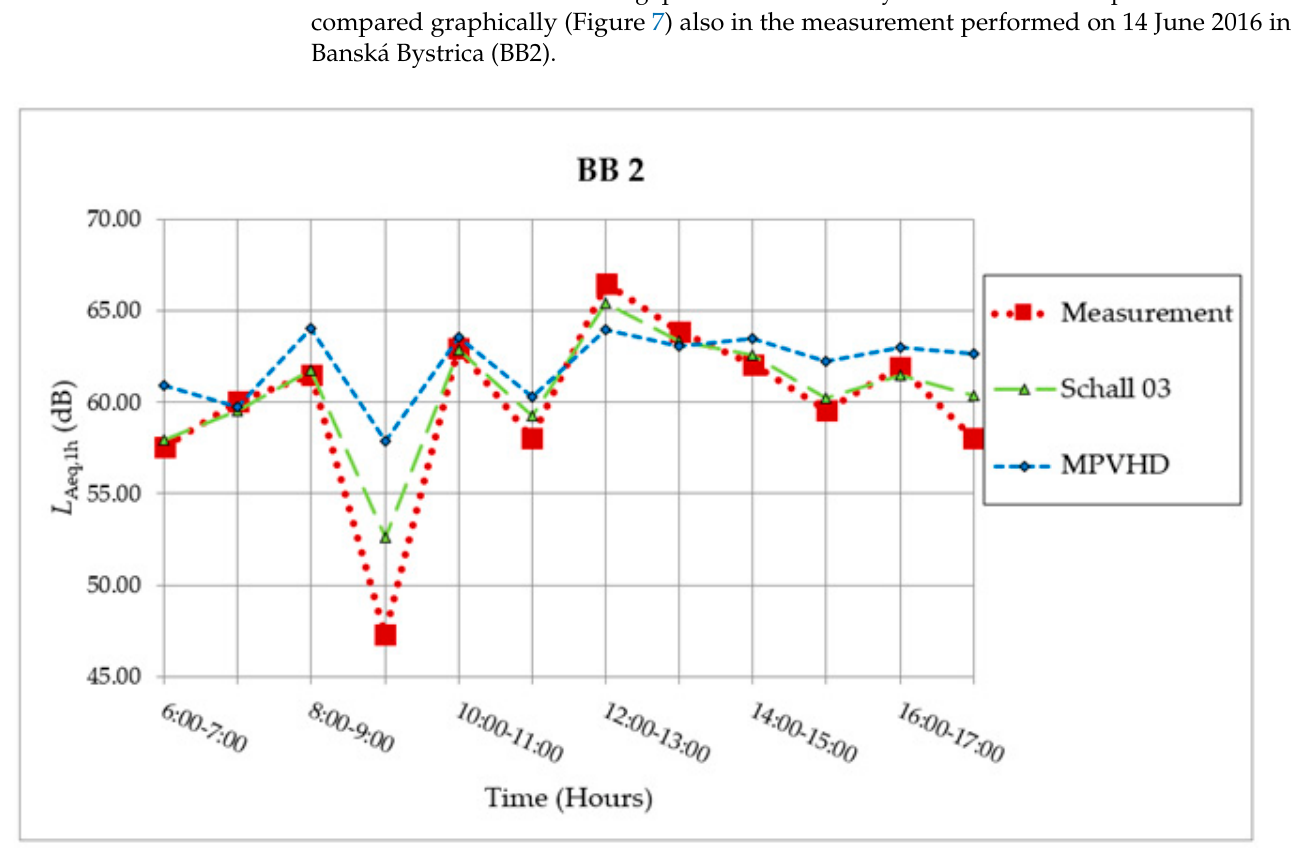
Figure 7. Measurement and prediction of noise from the railway on measurement location BB2 [30]. The maximum noise exposure was reached in the time interval from 12:00 a.m. to 1:00 p.m., although during this measurement hour only three trains passed near the BB2 location. However, one of the trains was freight, had 21 wagons, and passed in the direction of Vrútky-Banská Bystrica. The passage of the longest freight train was not recorded until the following hour. This train had 3 locomotives and 26 wagons, but it passed in the direction of Banská Bystrica - Č ervená Skala, i.e., on the line, which was twice as far from the measuring point. Although he passed 32 s longer, the L AE sound pressure level A was more than 5 dB lower. Between 9:00 a.m. and 10:00 p.m., only the passage of one motor passenger train with two wagons was recorded. A motor passenger train is a special train that is relatively short and moved with non-uniform movement. It was therefore prob- lematic to determine its speed and had a significantly different noise level than the basic noise emission level determined by both prediction models. As a result, the noise expo- sure at the given measuring point was the smallest. Train speeds ranged from 35 km/h to 75 km/h (average speed was 50 km/h). The equivalent sound pressure level A at the ref- erence time “day” for BB2 was L Aeq,12h = 61.58 dB. The course of determining quantities obtained by measurements and prediction methods has a similar tendency in this case as well. In the time interval between 9:00 a.m. and 10:00 a.m., the predictions are significantly overestimated by both methods (espe- cially in the case of MPVHD), at that time only one motor passenger train crossed through the assessed section. The sensitivity of both methods to this extreme situation is lower again. Box plots were also used in this measurement. The graph in Figure 8 again presents a comparison of L Aeq,1h levels obtained by prediction methods and measurements. The sta- tistical dataset obtained using the Schall 03 method has a similar (albeit slightly smaller) variance to the statistical file obtained by measurement. In the case of the MPVHD method, the variance of the data is again smaller than in other cases. All variances are markedly asymmetric. The horizontal march of the upper and lower quartiles is almost complete in the case of the Schall 03 method if it is only partial in the case of the MPVHD.